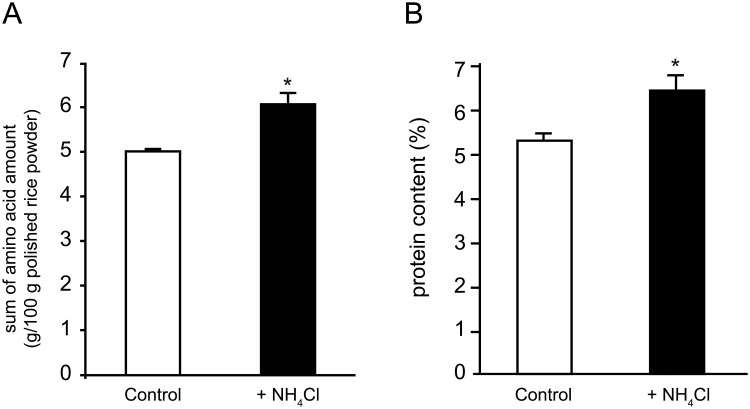
Amino acid and protein contents of mature polished rice cultivated in a field.Field trials were conducted for three years and data are expressed as means of the three trials. Filled bars correspond with samples from the N-fertilized plot and unfilled bars correspond with samples from the control plot. Error bars represent standard deviation (SD; *P<0.01) (A) Total amino acid content was analyzed after hydrolysis using hydrogen chloride. (B) Protein content was estimated using the Kjeldahl method.